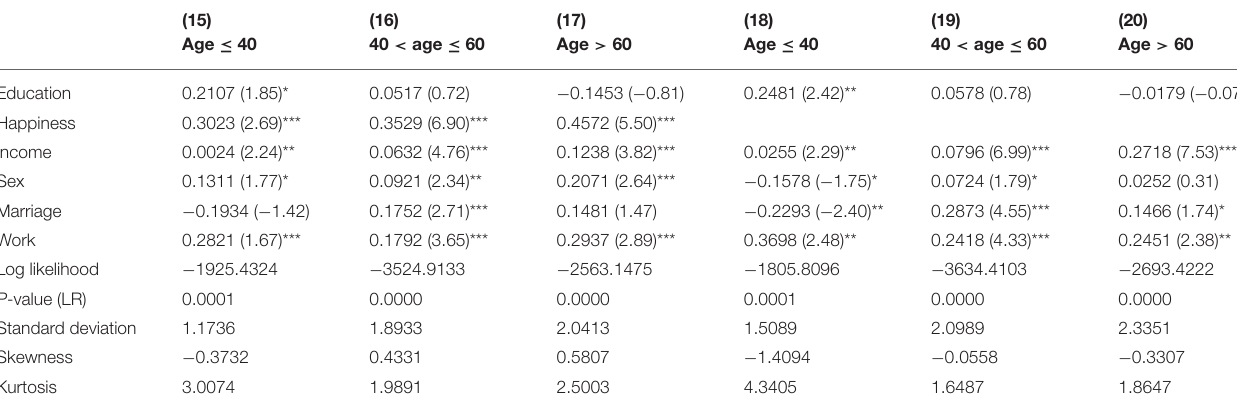
TABLE 6 | Grouping test results